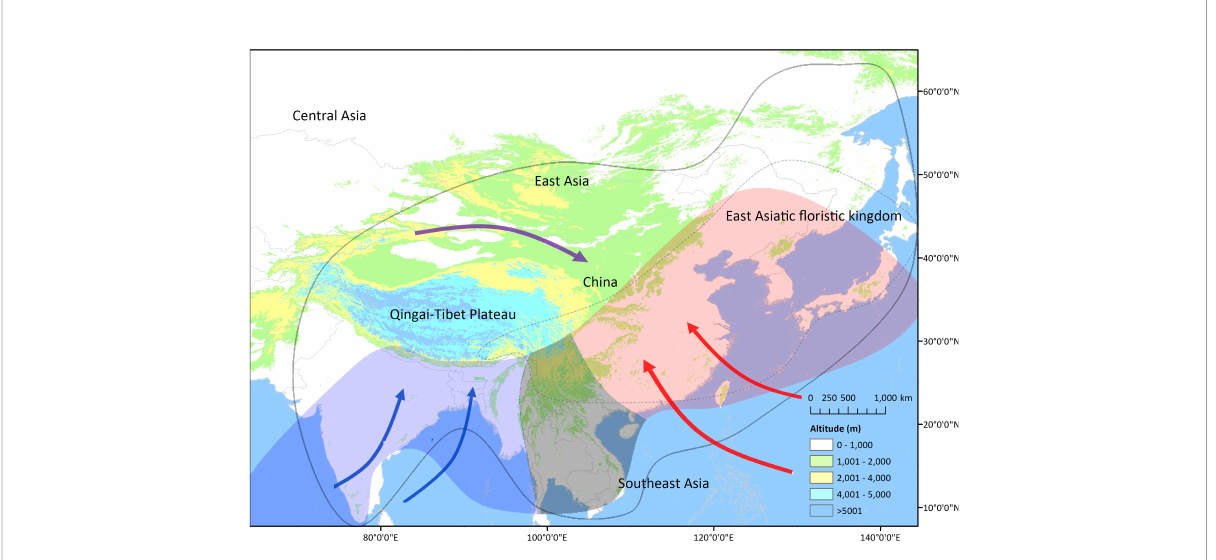
FIGURE 1 The East Asian monsoon system which encompasses the East Asian summer monsoon (EASM, red arrows), the Indian summer monsoon (ISM, blue arrows), and the Asian winter monsoon (AWM, purple arrows). Ranges of East Asia (Manchester et al., 2009) and East Asiatic fl oristic kingdom (Wu and Wu, 1996) are illustrated through a black line and a dotted line. The modern summer monsoon areas are those recognized by Wang and Ho (2002); red, blue, and gray areas indicate the EASM, ISM, and transitional region of the EASM and ISM,